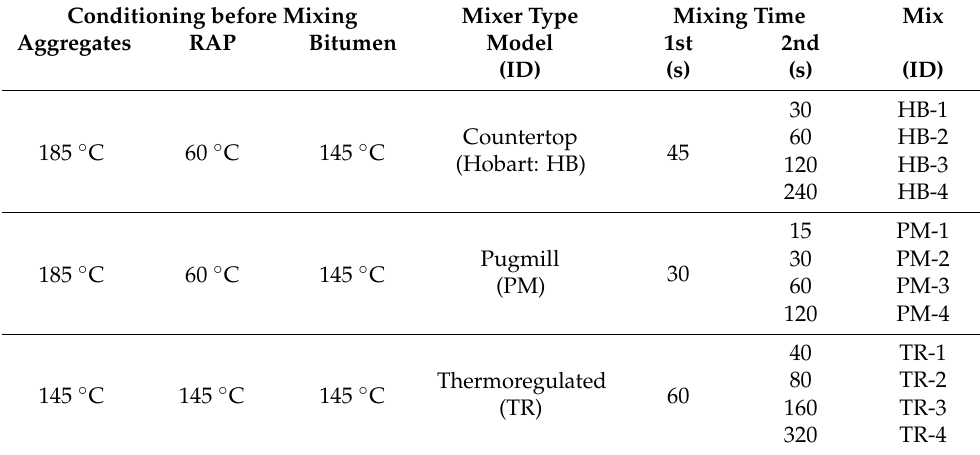
Table 4. Conditioning of materials before mixing, mixer type, and mixing time.